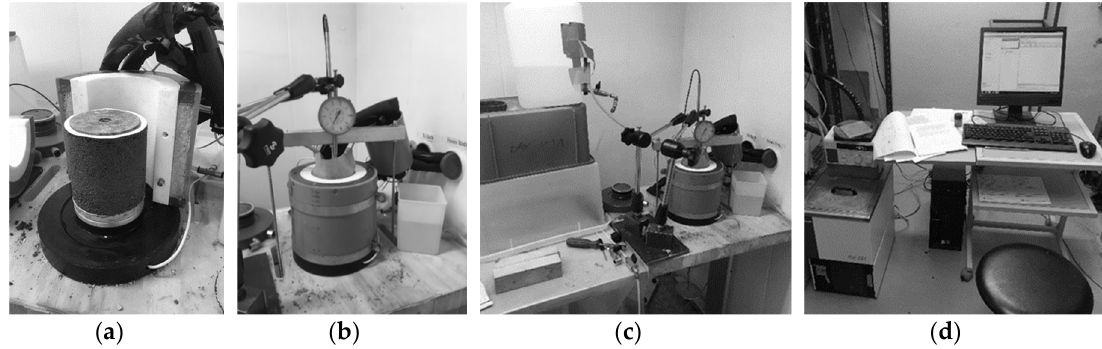
Figure 8. Frost heave test on quarry fine specimen: ( a ) Frozen quarry fine specimen mounted on the test apparatus; ( b ) Assembled specimen; ( c ) Assembled specimen with water supply; ( d ) Computer and temperature control system).